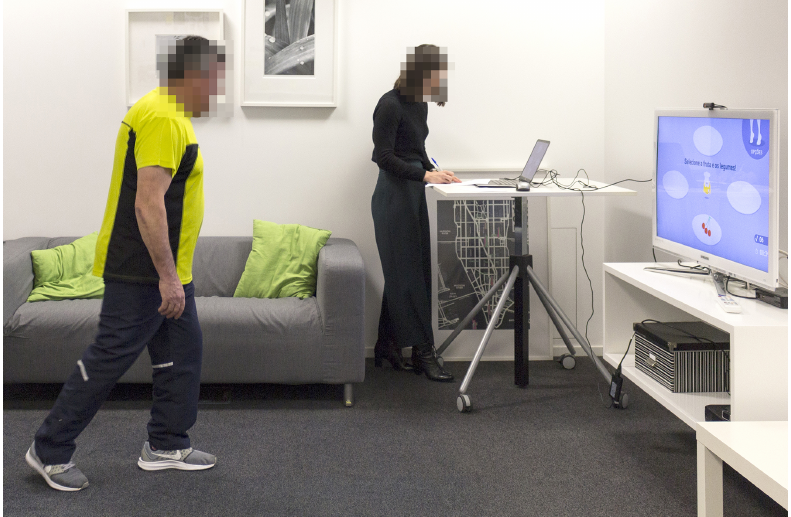
Figure 4. VITAAL exergame gameplay: interacting with the exergame by performing multidirec- tional